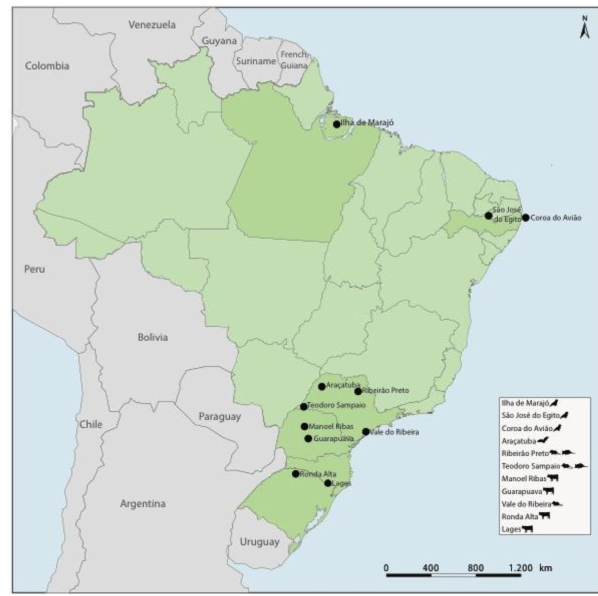
Figure 1. Geographic locations of collected samples in